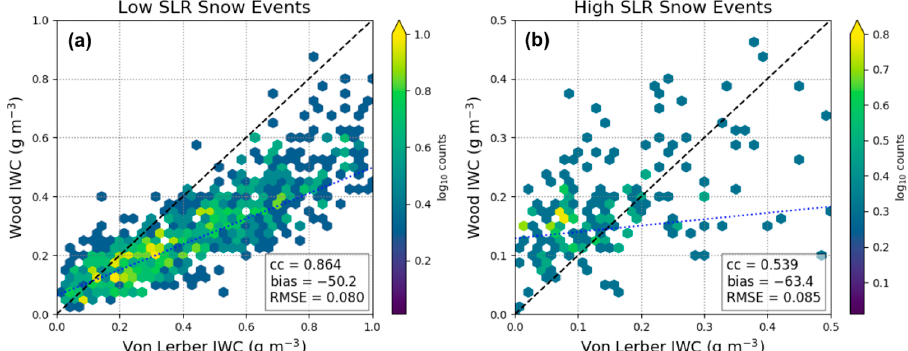
Figure 6. Shown are comparisons of five-minute values of IWC from the von Lerber and Wood retrievals for the low SLR ( a ) and high SLR ( b ) snow events. The von Lerber IWC is on the x-axes and the Wood IWC on the y-axes. There are fewer points in the Wood-retrieved output due to the filtering of times when the Pluvio does not report any accumulation, resulting in fewer comparisons of retrieved mass overall, but particularly in the high SLR events. The black dashed line represents a 1:1 relationship, while the blue dotted line is the linear regression fit to the data.